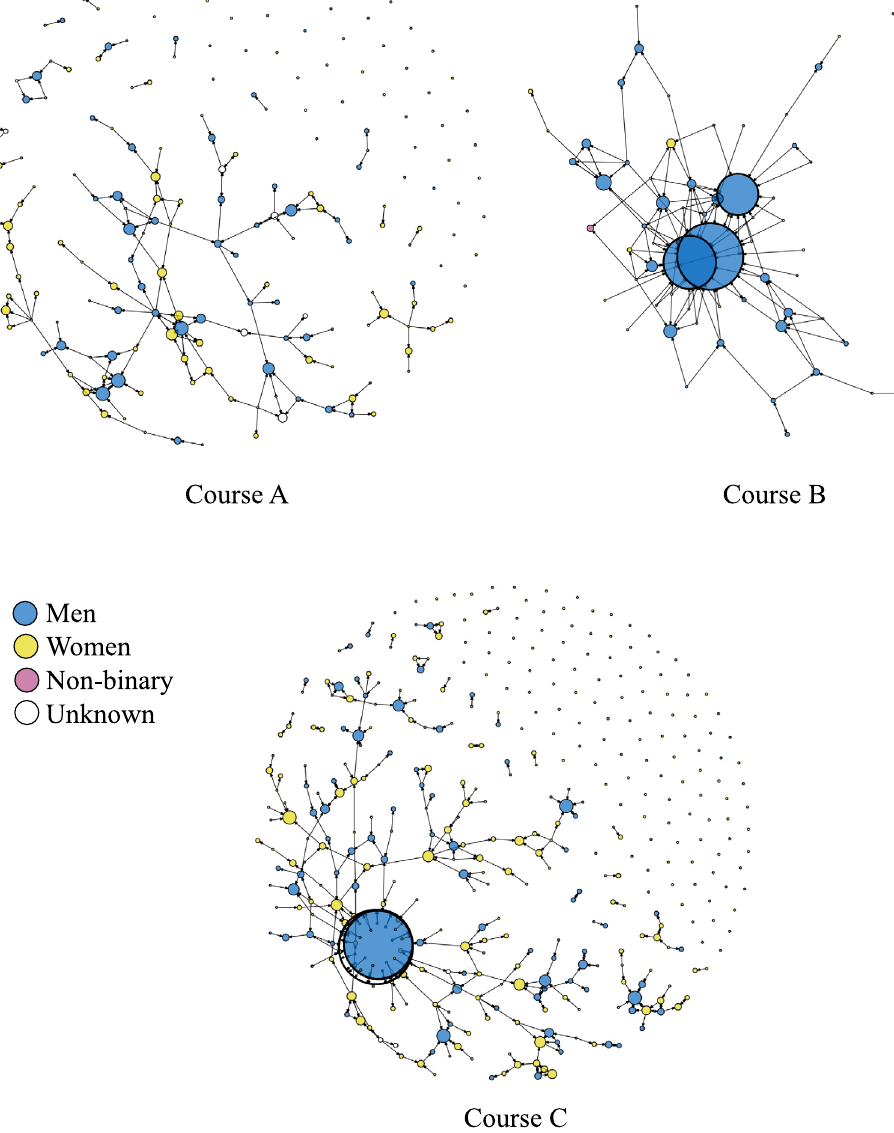
FIG. 1. Lecture perception networks. Nodes are colored by self-reported gender and sized proportional to indegree (number of received nominations). Nodes with bold outlines indicate celebrities (three in Course B and two in Course C). Edges point from the nominator to the